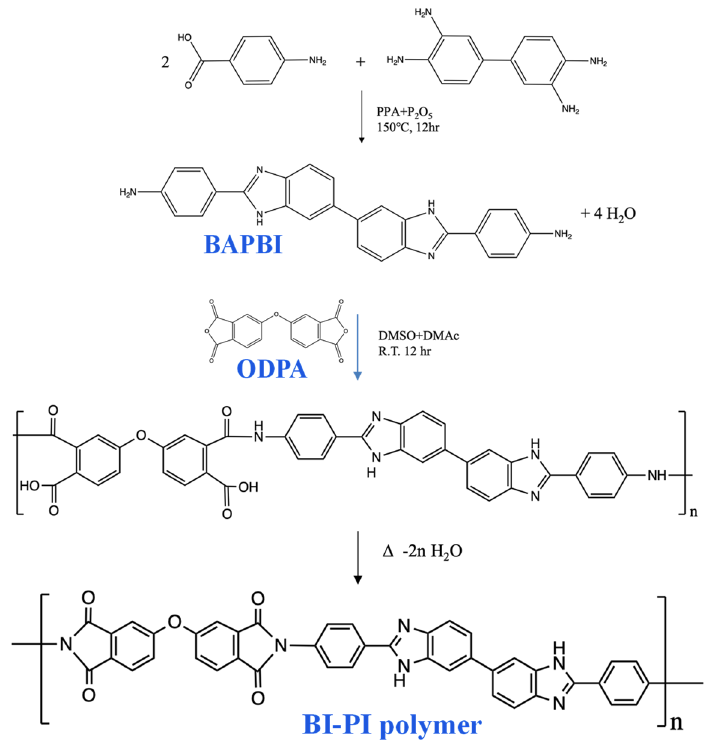
Figure 1. Synthesis of BI-PI polymer containing